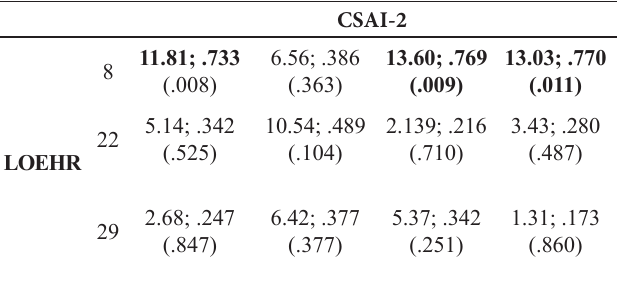
Table 2 below represents the resulting data from the cor- relation between the CSAI-2 and LOEHR selected items on the variable self-confidence. Table 2. CSAI-2 and LOEHR selected items for the correlational study of